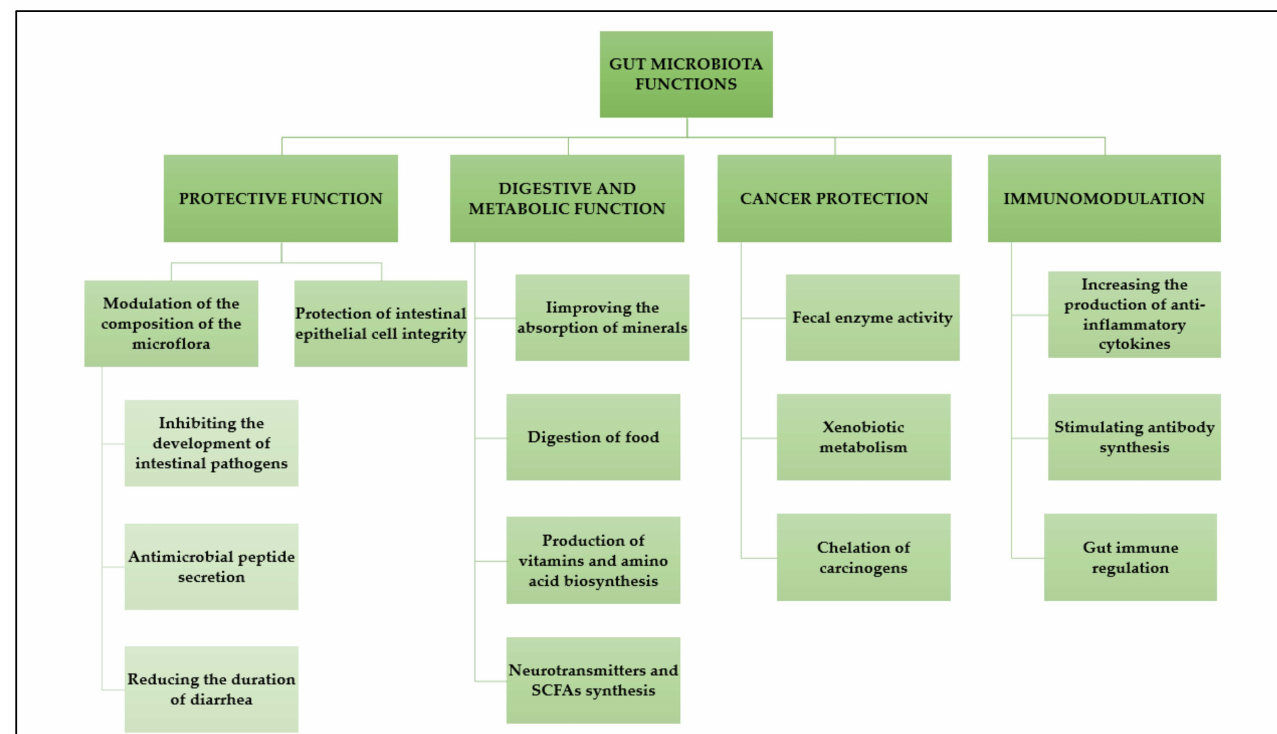
Figure 2. Functions of the gut microbiota